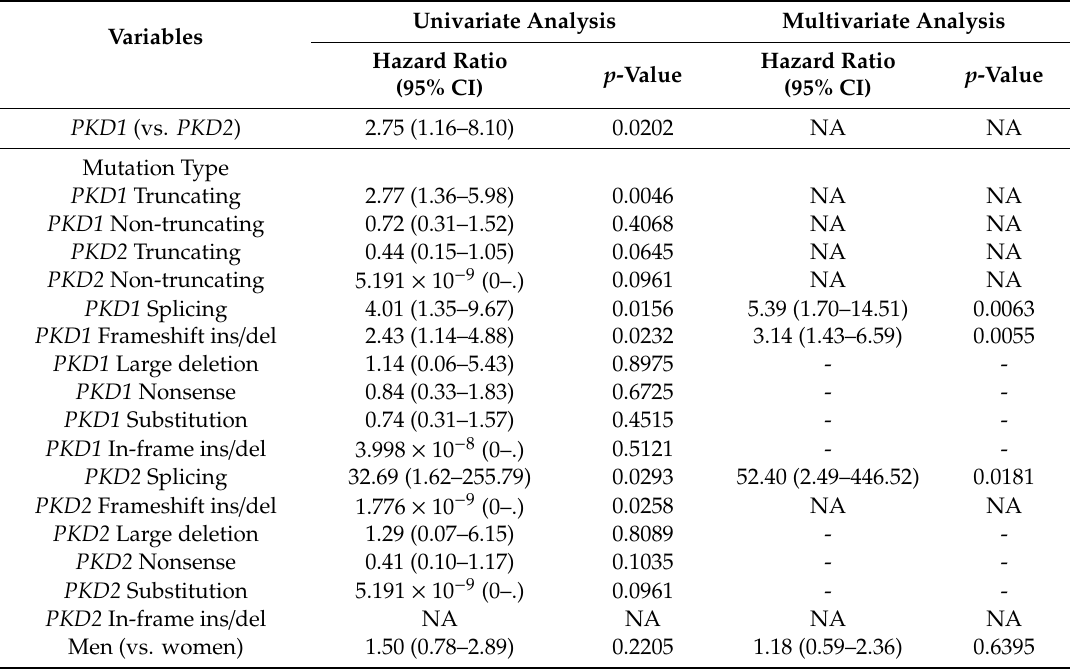
Figure 1. Age at RRT. RRT = renal replacement therapy. Table 2. Univariate and multivariate analysis of risk factors associated with RRT (Entire cohort, n = 123; Model